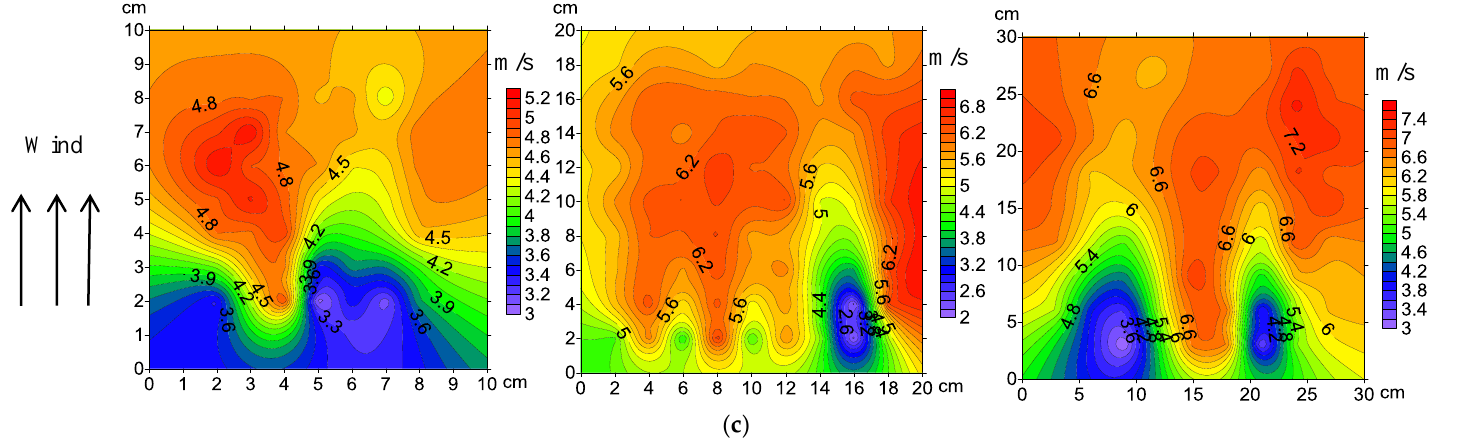
Figure 5. Flow fields for straw checkerboards of different side lengths and wind speeds: ( a ) 5 m·s −1 , ( b ) 8 m·s –1 , and ( c ) 11 m·s –1 . Straw lengths from left to right are 10, 20, and 30 cm.